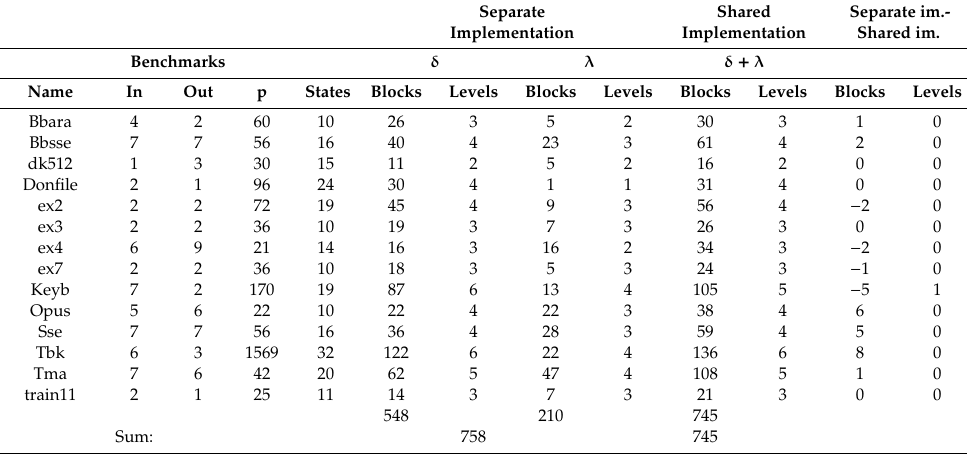
Table 2. Results of experiments (ABC, number of states ≥